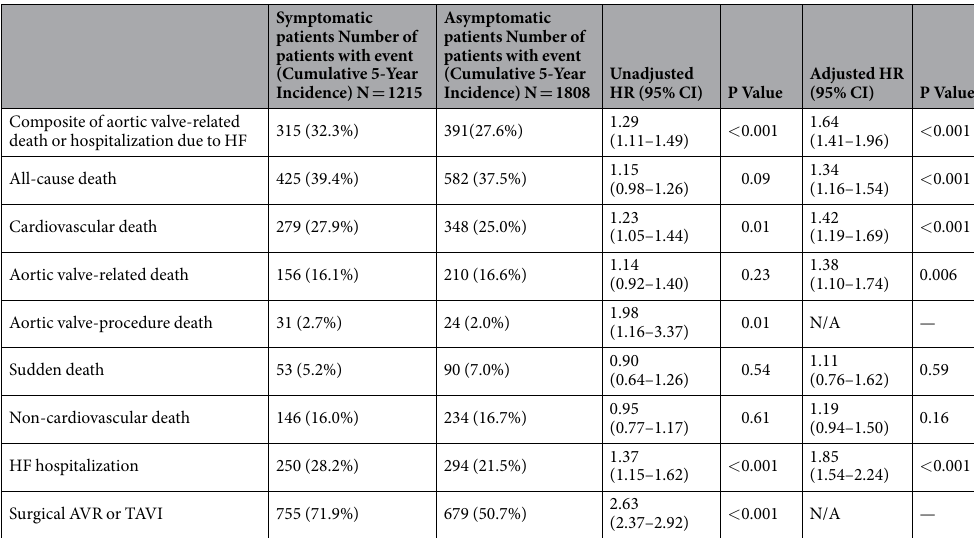
Table 2. Clinical outcomes: Symptomatic versus Asymptomatic patients. The number of patients with event was counted through the entire follow-up period, while the cumulative 5-year incidence was truncated at 5-year. Any death during hospitalization for AVR or TAVI was regarded as aortic procedure-related death. Aortic valve-related death included aortic procedure-related death, sudden death, and death due to HF. HF hospitalization was defined as hospitalization due to worsening HF requiring intravenous drug therapy. Risk- adjusting variables: Initial AVR strategy and 18 clinically relevant risk-adjusting variables: age, sex, body mass index, hypertension, current smoking, diabetes on insulin, coronary artery disease, prior myocardial infarction, prior symptomatic stroke, aorta/peripheral artery disease, serum creatinine, hemodialysis, anemia, liver cirrhosis, malignancy currently under treatment, chronic lung disease, any valvular disease, and AS severity. AS = aortic stenosis; AVR = aortic valve replacement; CI = confidence interval; HF = heart failure; HR = hazard ratio; N/A = not assessed; TAVI = transcatheter aortic valve implantation.